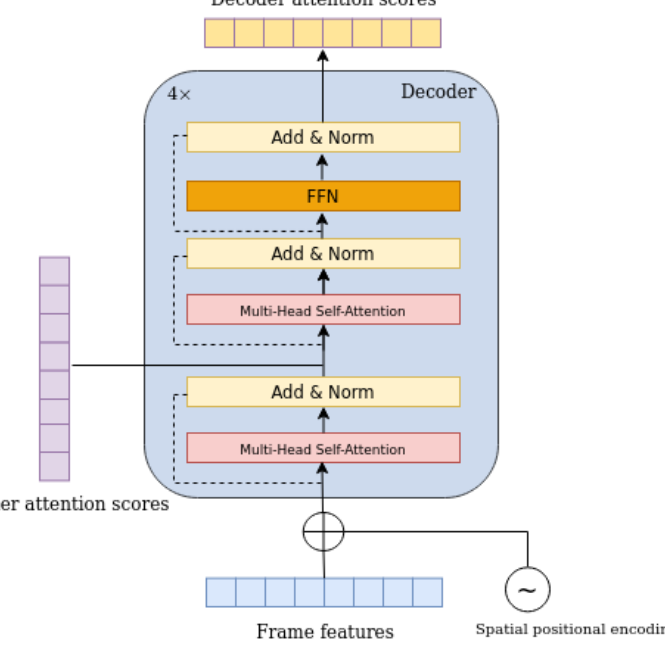
Figure 5. In this figure, the decoder layer architecture is depicted. The decoder of the model consists of four identical, consecutive